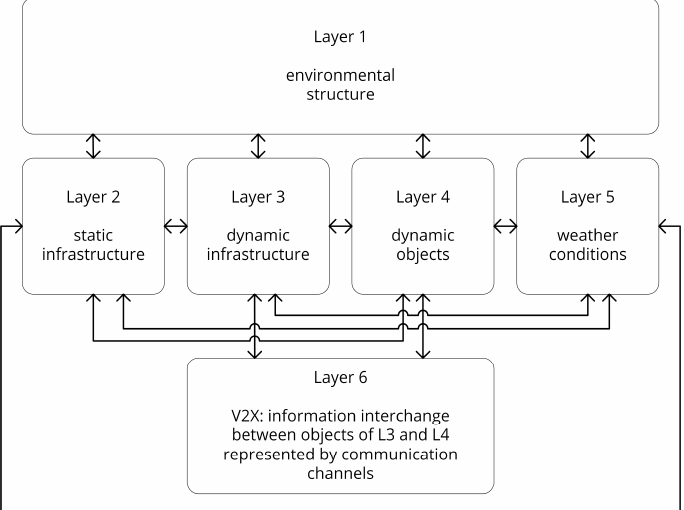
Figure 14. The 6-layer-model (6LM) used to organize the possible contents of a scenario thematically and structurally. Slightly extended to visualize the interactions possible here, based on [51]. Possible interactions are indicated by arrows between the layers. The original Layer 3 “Temporal Modifica- tions” has been replaced by “Dynamic Infrastructure”. In this layer, infrastructures with bounded mobility (buoys, mobile barriers, etc.) as well as communicating infrastructures (lighthouses, traffic lights) are to be included in order to achieve a clearer distinction from purely static